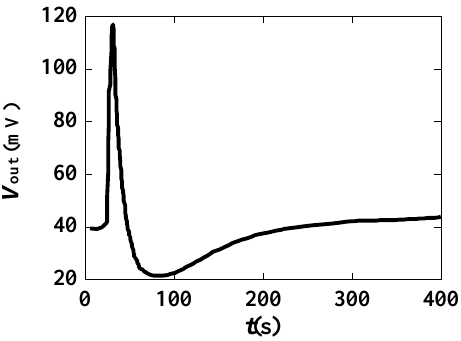
Figure 19. Typical step response of the sensor.